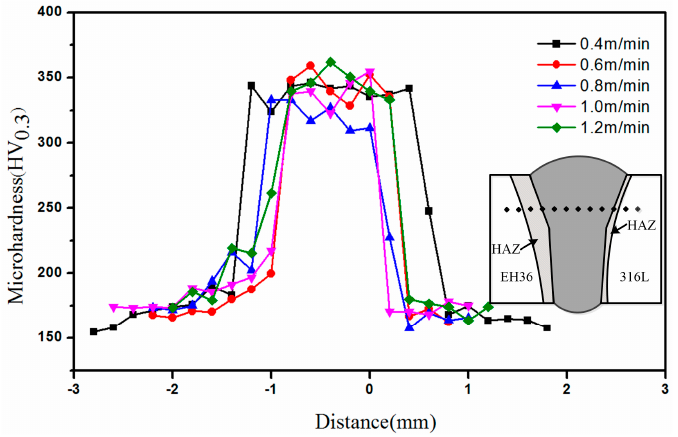
Figure 9. Microhardness profile of the joint across section.